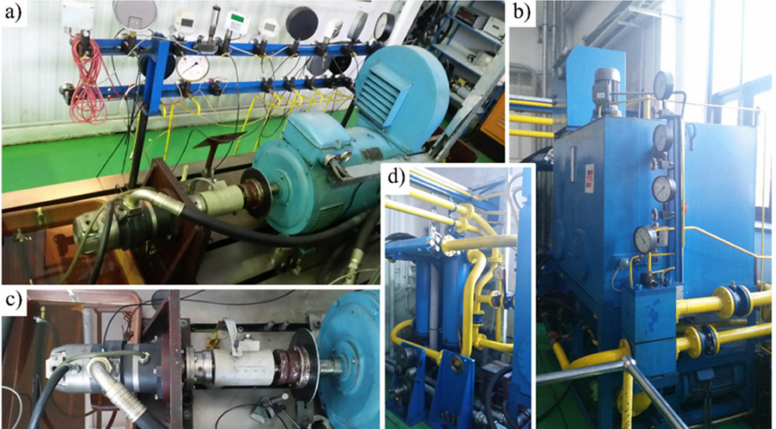
Figure 7. Hydraulic test stand at Gdansk University of Technology [12]: ( a ) driveline and pressure measurement equipment; ( b ) tank; ( c ) pump and mechanical parameter measurement equipment; ( d ) coolers and heaters.